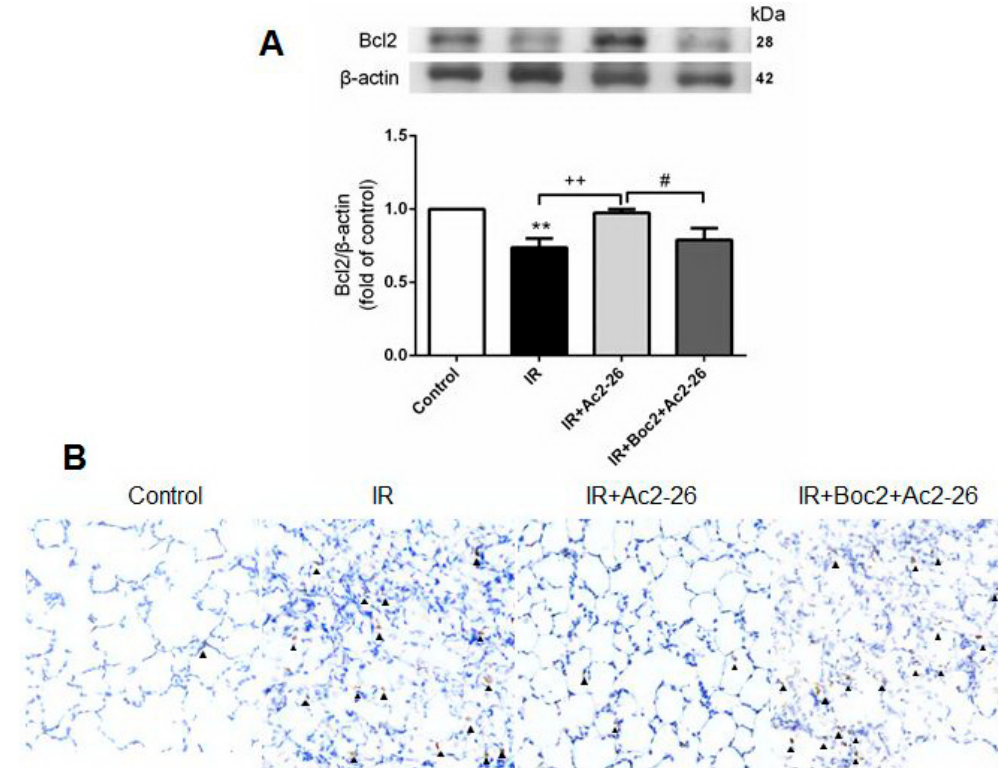
Figure 7. Effect of Ac2-26 and Boc2 on the expression of B-cell lymphoma (Bcl)-2 and caspase-3 in lung tissue. ( A ) Western blot analysis of Bcl-2 protein in the lung tissue. β -actin served as a loading control for cytoplasmic proteins. Representative blots are shown; ( B ) Immunohistochemistry for active caspase-3 in the lung (indicated with an arrowhead) (200× magnification). IR significantly decreased Bcl-2 protein expression and induced caspase-3 activation in the lung tissue. Ac2-26 treatment significantly increased Bcl-2 protein expression and attenuated the signals for active caspase-3 in the IR group. When Boc2 was added, the protective effect was blocked. Representative blots are shown. Data are expressed as means ± SD ( n = 6 per group). ** p < 0.01, compared with the control group; ++ p < 0.01, compared with the IR group; and # p < 0.05, compared with the IR + Ac2-26 group.